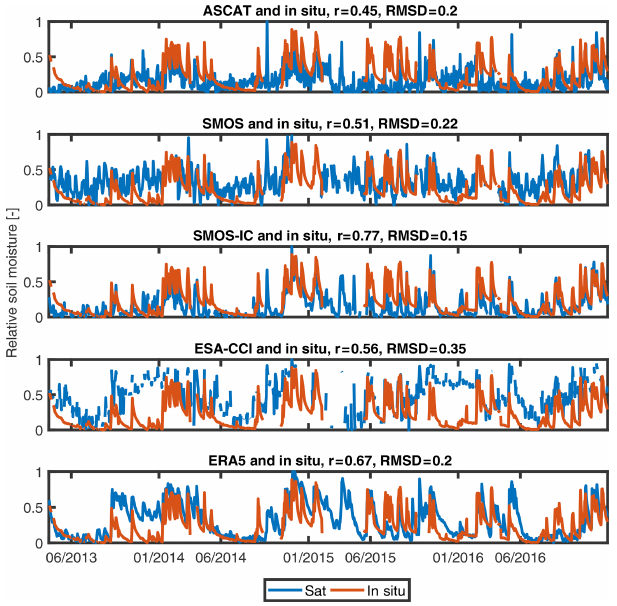
Figure 4. Relationship between the different products of soil mois- ture and SMA model outputs between 8 April 2013 and 31 Decem- ber 2016 over the Rheraya